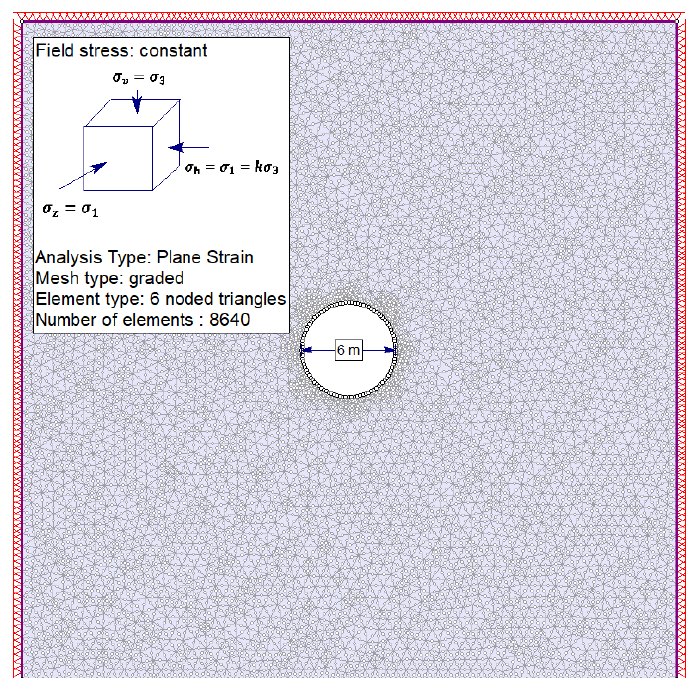
Figure 5. RS2 numerical model and key characteristics used to compare the equivalent Mohr-Coulomb (EMC) and generalized Hoek-Brown (GHB) criteria.